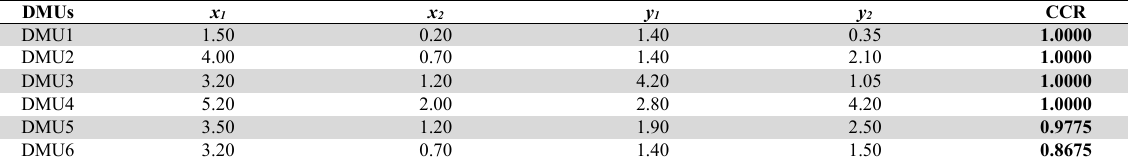
Data set of six nursing homes DMUs